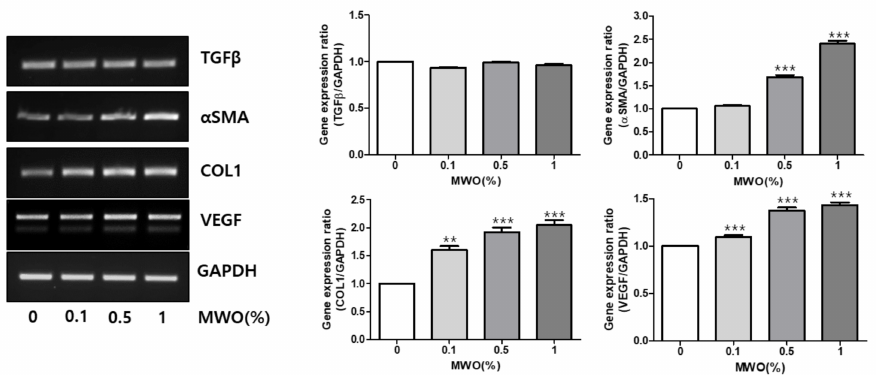
Figure 2. Expression of genes related to wound healing by MWO in fibroblasts. Fibroblast cells were treated with the indicated concentrations of MWO for 24 h. Total RNA was isolated from NIH-3T3 cells. RT–PCR was performed to analyze the mRNA expression of each gene using gene-specific primers, as described in Table 1. GAPDH was used as an internal control. The values are shown as means ± SD. ** p < 0.01 and *** p < 0.001 compared to the control. Table 1. Primers used for PCR of TGF- β 1, α -SMA, COL-1, VEGF and GAPDH. Gene Primer Sequences PCR Condition Size (bp) mTGF- β